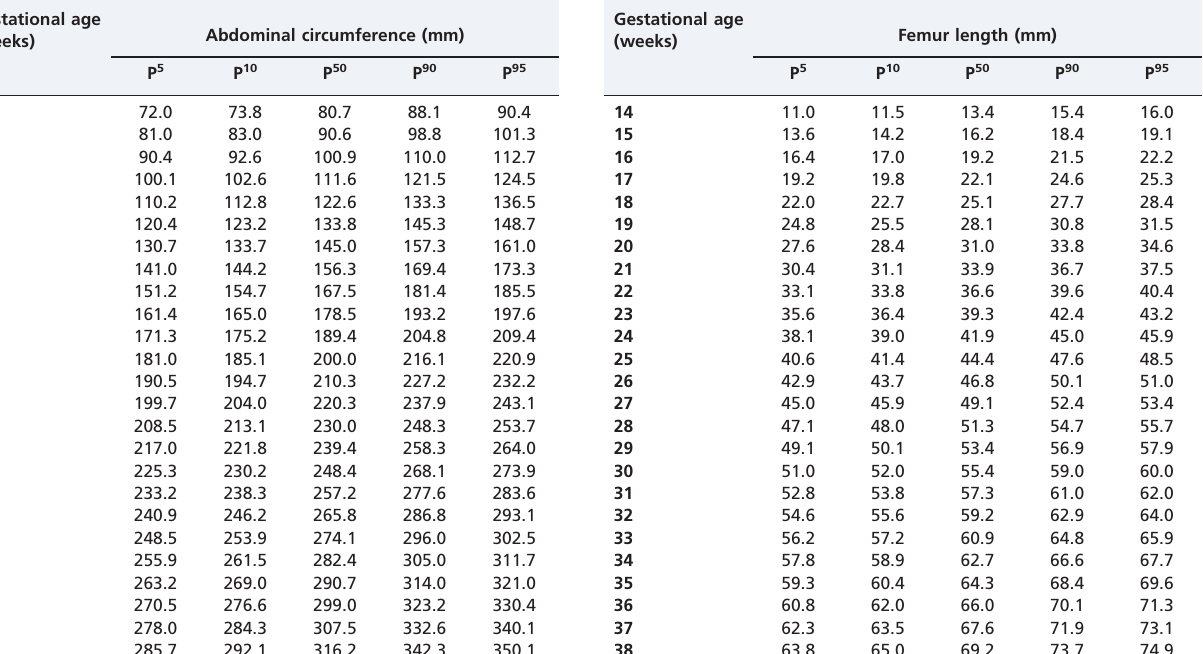
Table 5 - Longitudinal reference ranges for femur diaphysis length based on 807 ultrasound examinations